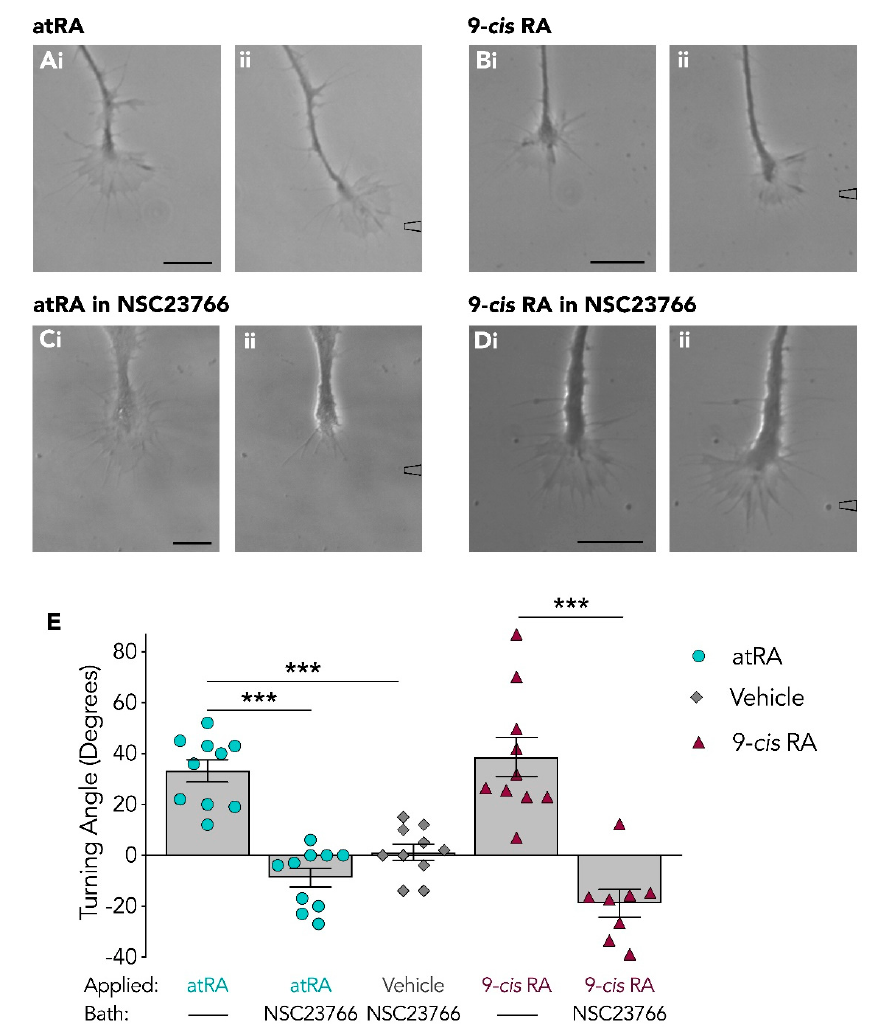
Figure 3. Growth cone turning mediated by retinoids is blocked by the inhibition of Rac. Application of atRA ( Ai – ii ; n = 10; t = 23) and 9- cis RA ( Bi – ii ; n = 10; t = 19) induced attractive growth cone turning. In the presence of the Rac inhibitor, NSC23766, growth cones failed to turn toward either atRA ( Ci – ii ; n = 10; t = 30) or 9- cis RA ( Di – ii ; n = 8; t = 14). Scale bars: 15 µ M. ( E ) Graph depicting the mean turning angle of growth cones in response to application of atRA or 9- cis RA, both in the presence and absence of NSC23766. The turning response to the vehicle in NSC23766 is also given. NSC23766 significantly reduced the mean turning angle of growth cones in response to each retinoid (*** p < 0.001). NSC23766 did not however induce significant differences in growth cone turning responses to retinoid application compared to vehicle application.